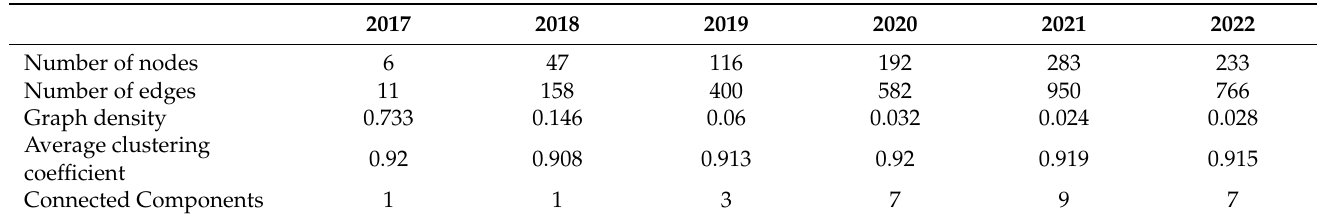
Table 1. Global network measures for the dynamic analysis of the supra-regional network from 2017 to 2022.